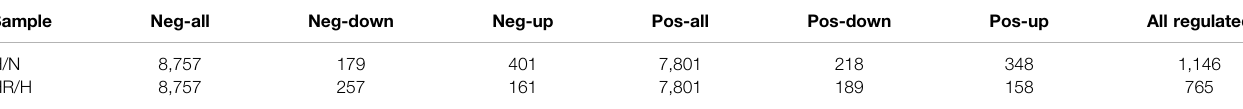
TABLE 1 | Number of differentially expressed metabolites between groups. Sample